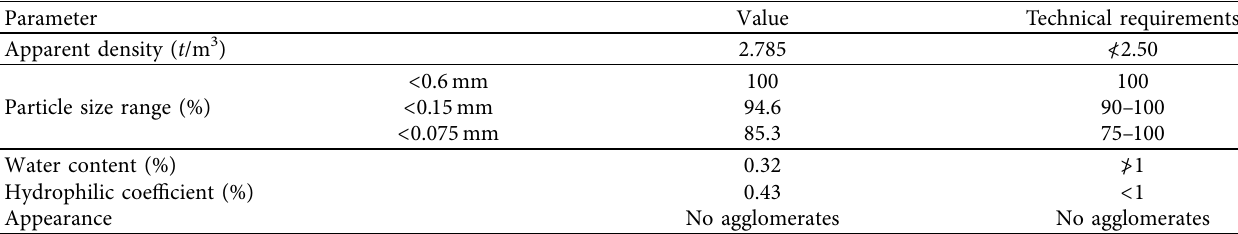
Table 3: Physical properties of fller.